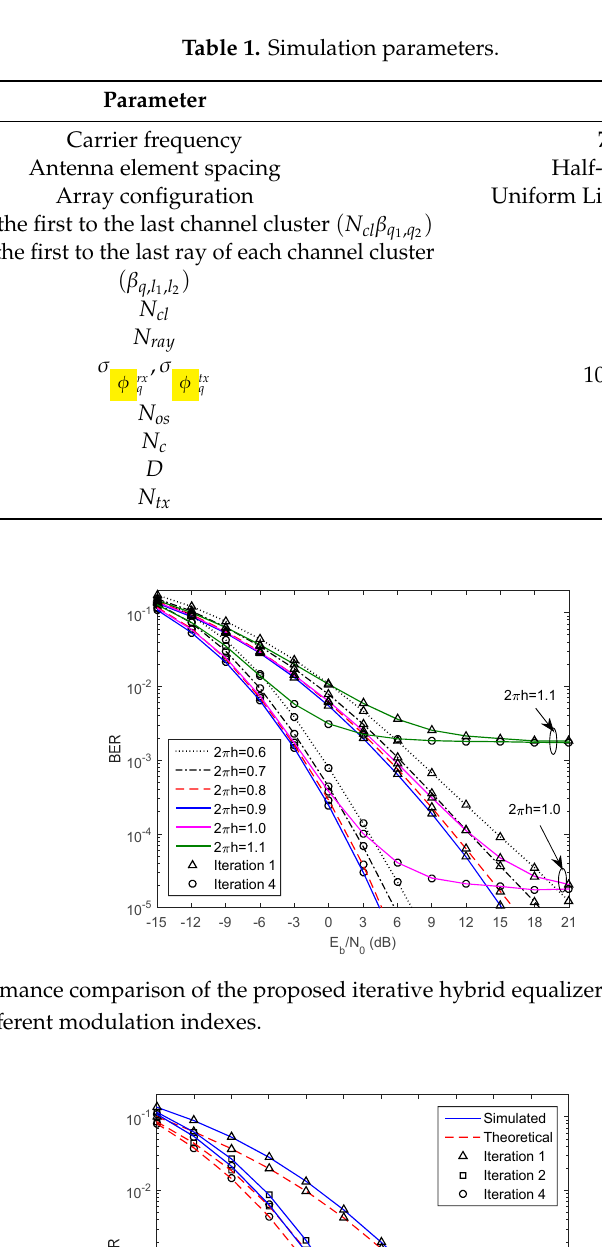
Figure 4. Performance of the proposed iterative hybrid equalizer and semi-analytic bit-error-rate (BER) approximation, with 8 RF